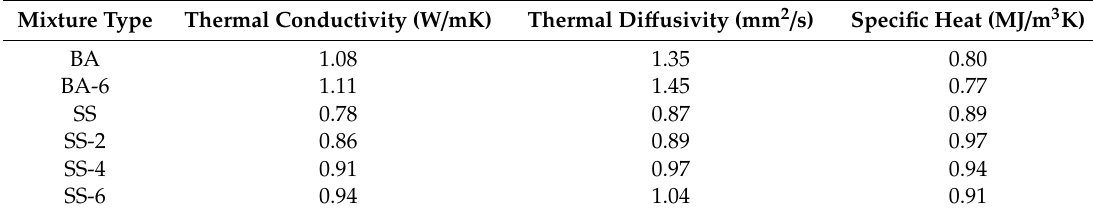
Table 5. Thermal properties of di ff erent asphalt